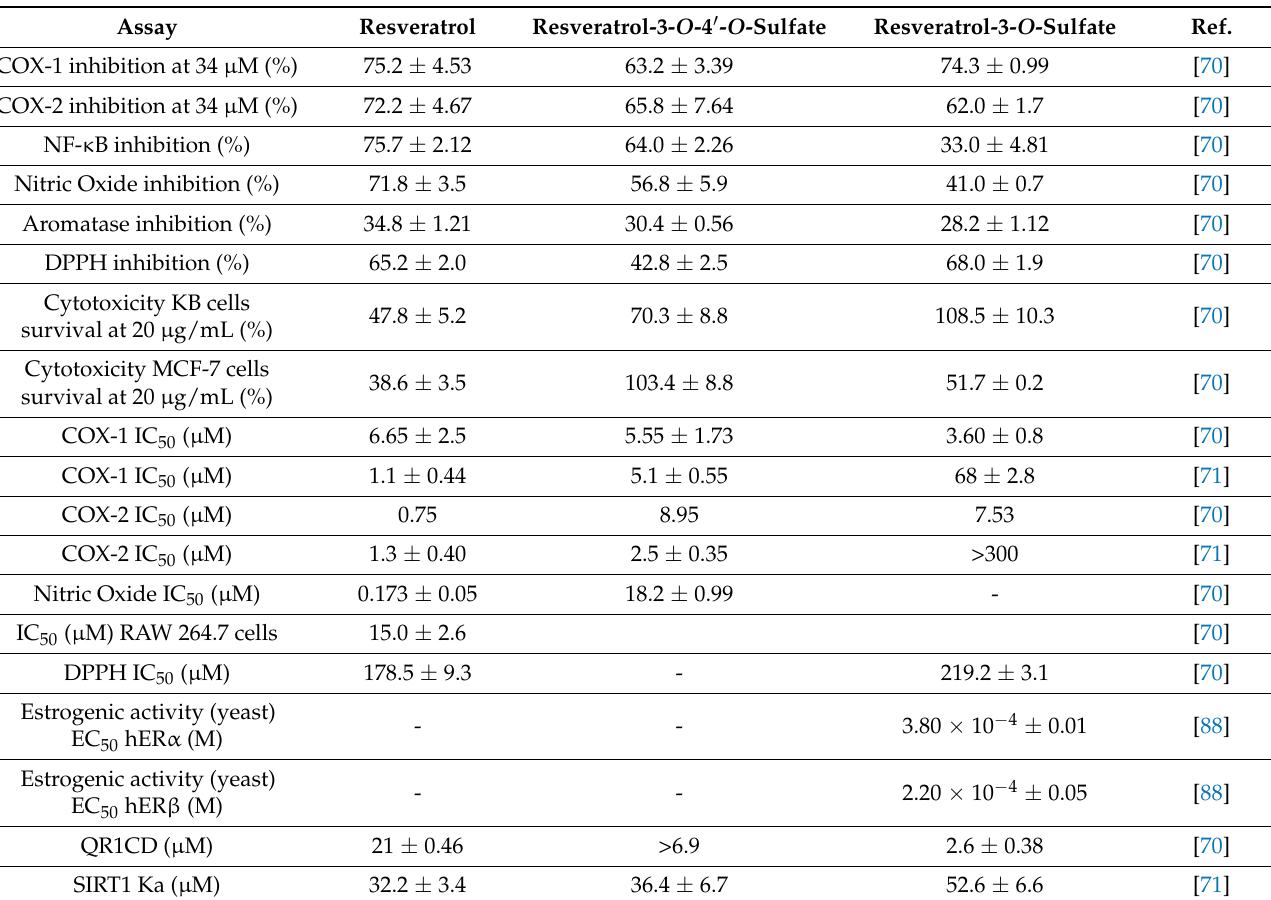
Table 1. The basic biochemical parameters of resveratrol and its sulfates, indicating their cancer chemopreventive